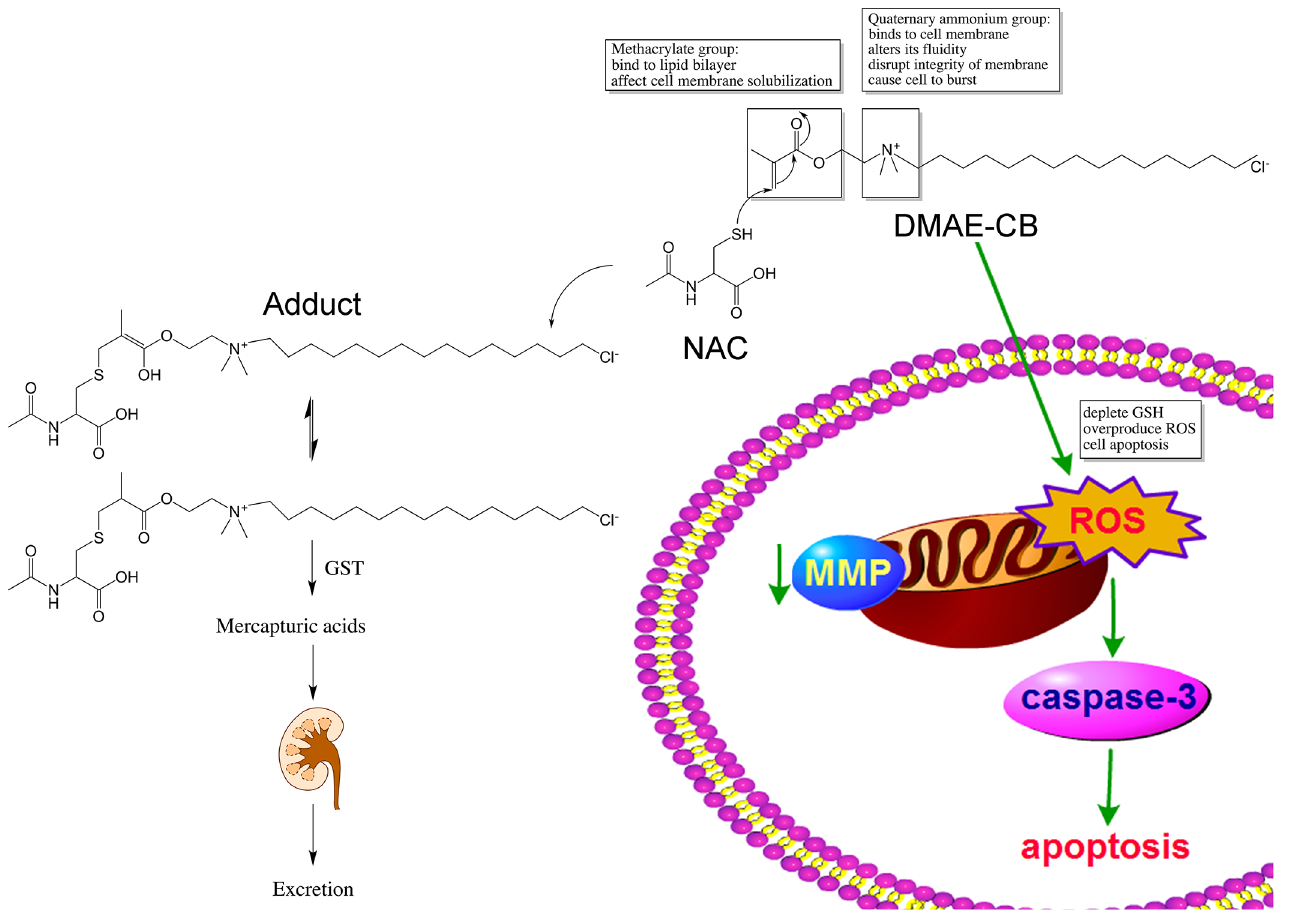
Fig 5. A schematic diagram summarizing the toxicity of the antibacterial monomer DMAE-CB and rescuing effects of NAC. DMAE-CB-induced apoptosis was correlated with the generation of increased ROS level accompanied with reduced GSH content which was followed by the collapsed miltochondrial membrane potential (MMP) and activation of caspase-3. The chemical reaction between NAC and DMAE-CB resulting in the formation of the 1:1 DMAE-CB-NAC adduct through Michael addition reaction, and thus reduce the cytotoxic effect of DMAE-CB. The reaction may result in two isomers, the enol form and the keto form, and a chemical equilibrium may exist between the two forms. The formed NAC-DMAE-CB adduct are likely to be transformed to mercapturic acids catalyzed by Glutathione S-transferases (GST) and eventually excreted with urine.